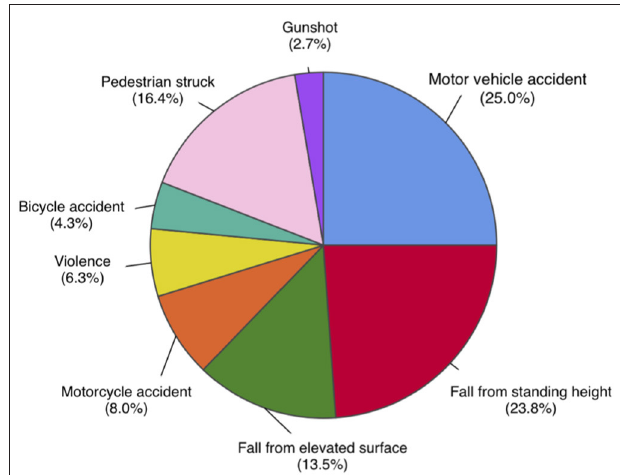
FIGURE 1 | Distribution of mechanisms of injury in total study population, n = 530. Road traffic accidents, including motor vehicle, motorcycle, bicycle accidents, and pedestrian struck, are most common mechanisms of injury, accounting for a total of 282 (53.7%) cases. Fall from elevated and standing heights is second most common, accounting for 196 (37.3%) cases. Other mechanisms include violence and gunshot